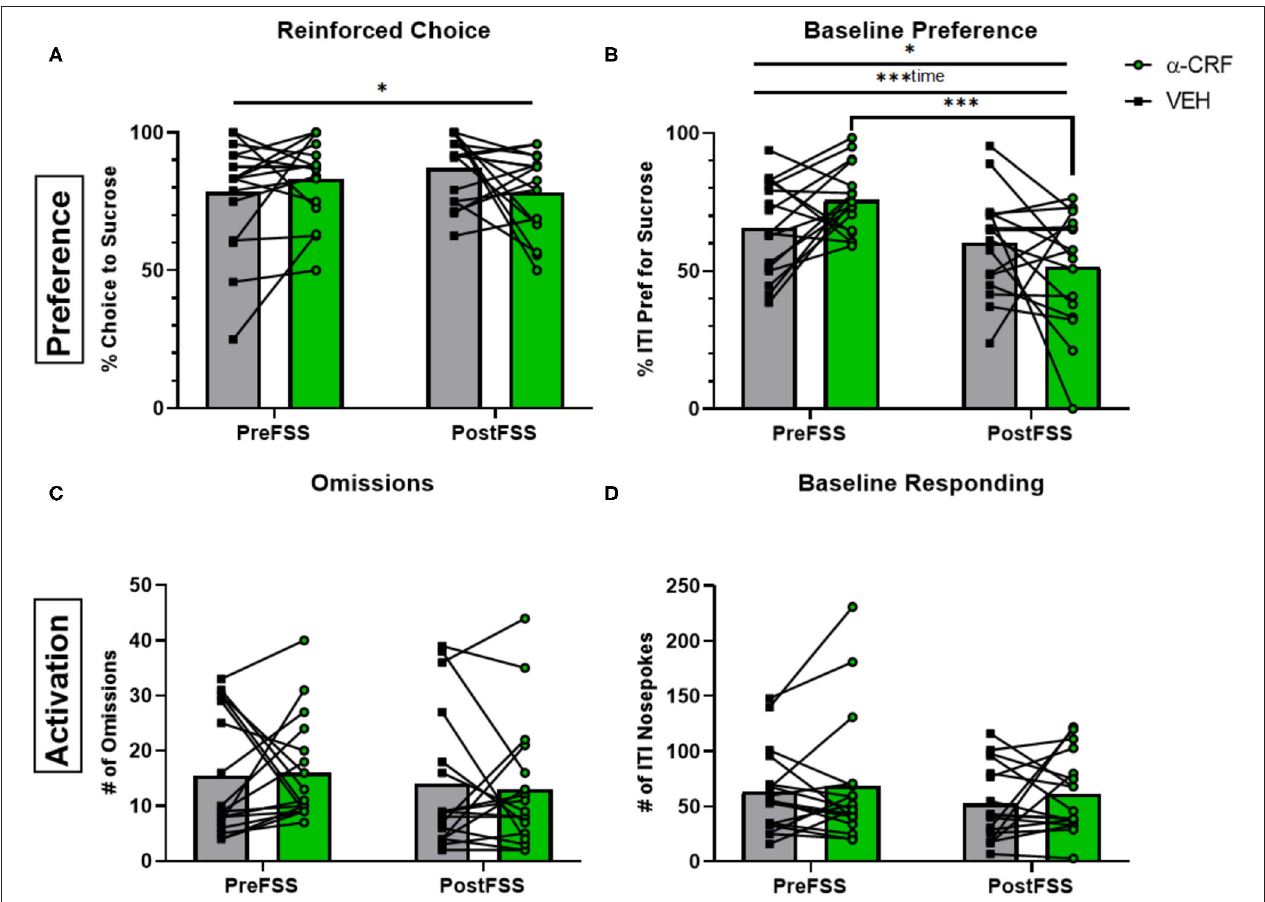
FIGURE 5 | Influence of CRF antagonism on decision-making behaviors. (A) Averaged percentage of reinforced choice for the sucrose liquid receptacle in free-choice trials in sessions before (PreFSS) and after (PostFSS) the rFSS for animals receiving either α -helical CRF (9 − 41) (500 ng/200 nL; Tocris Bioscience; n = 17) or its vehicle (0.01% acetic acid in lactated ringer’s solution; n = 17). (B) Percentage of ITI nosepokes made during the session for the sucrose liquid receptacle compared to water receptacle nosepokes during the ITI. (C) Total number of omissions made during the sessions. (D) Total number of ITI nosepokes made at all during the sessions. Error bars are ( ± SEM). * P < 0.05, *** P <